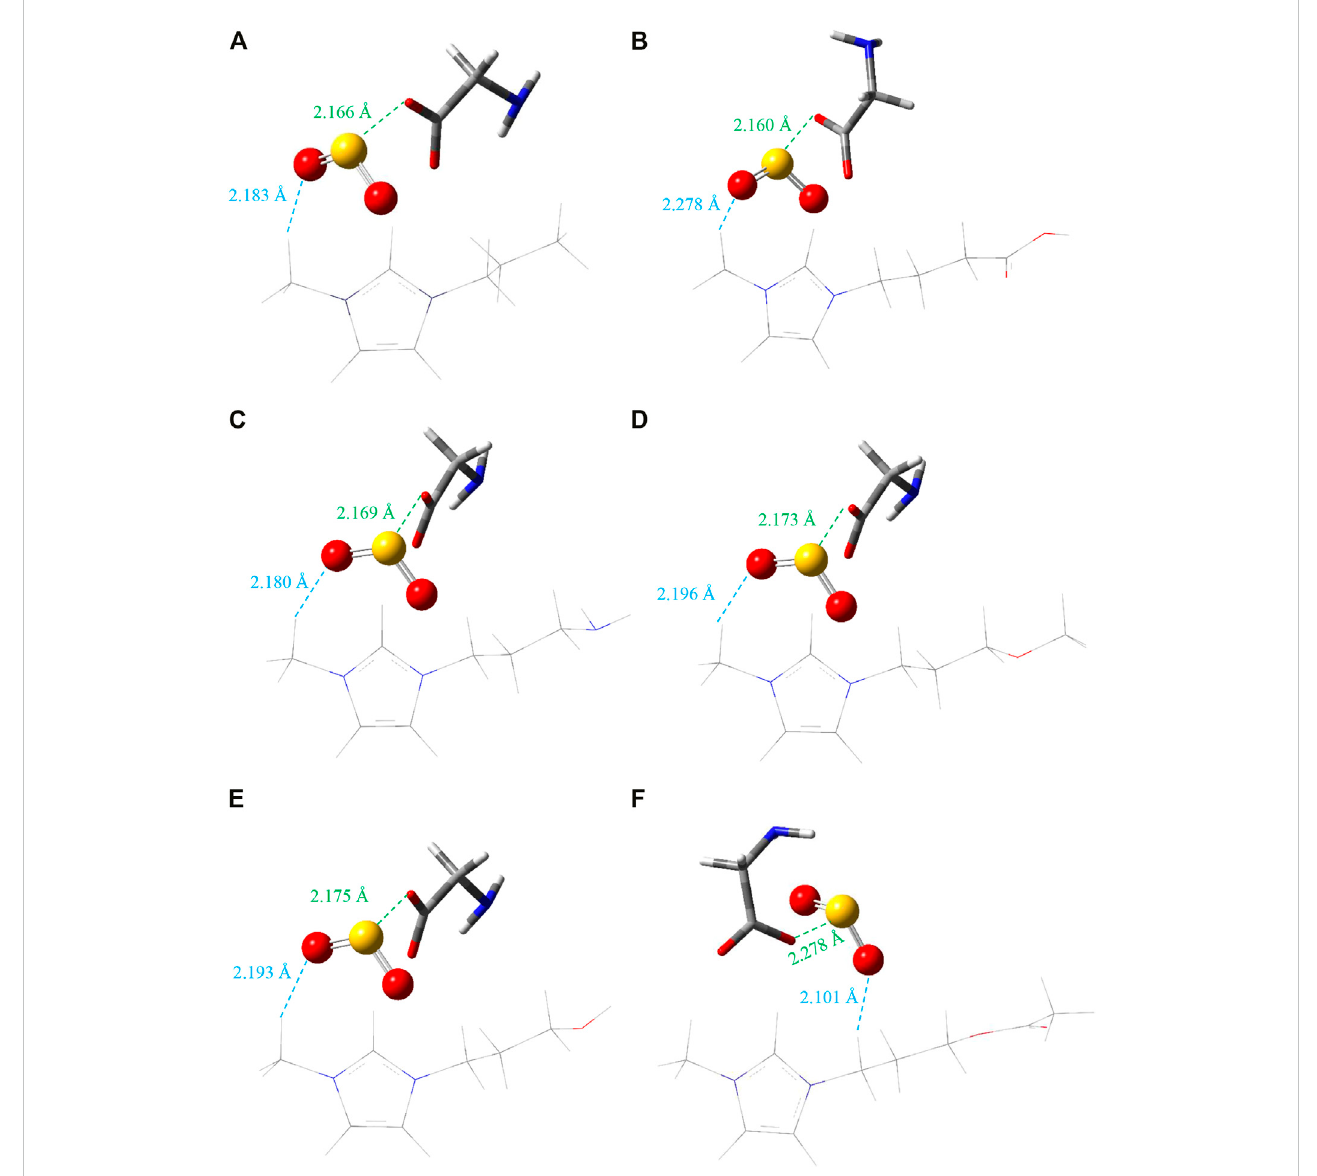
The most stable geometry for studied AAIL ... SO 2 complexes. The white, gray, blue, red, and yellow denote H, C, N, O, and S atoms, respectively. The closest distance (Å) between cation ... SO 2 and anion ... SO 2 is represented in each case. (A) [C 3 MIM][GLY], (B) [C 3 COOHMIM][GLY], (C) [C 3 NH 2 MIM][GLY],